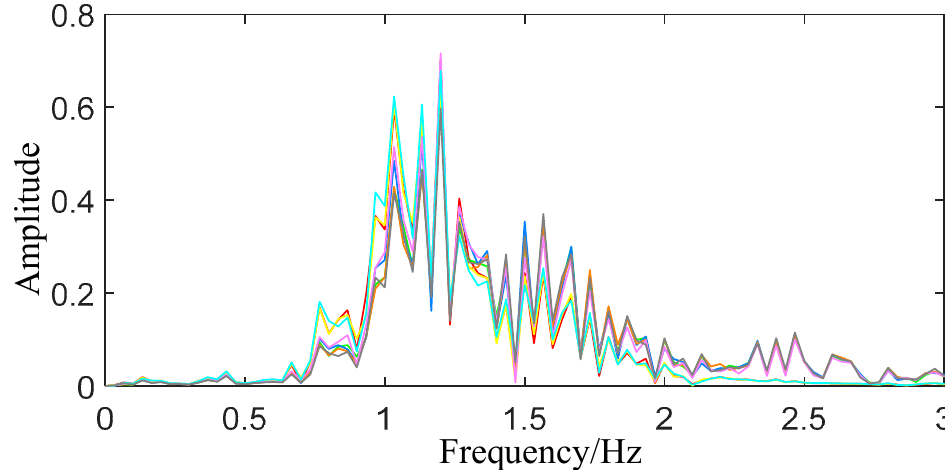
Figure 9. Spectrogram of respiratory signal.